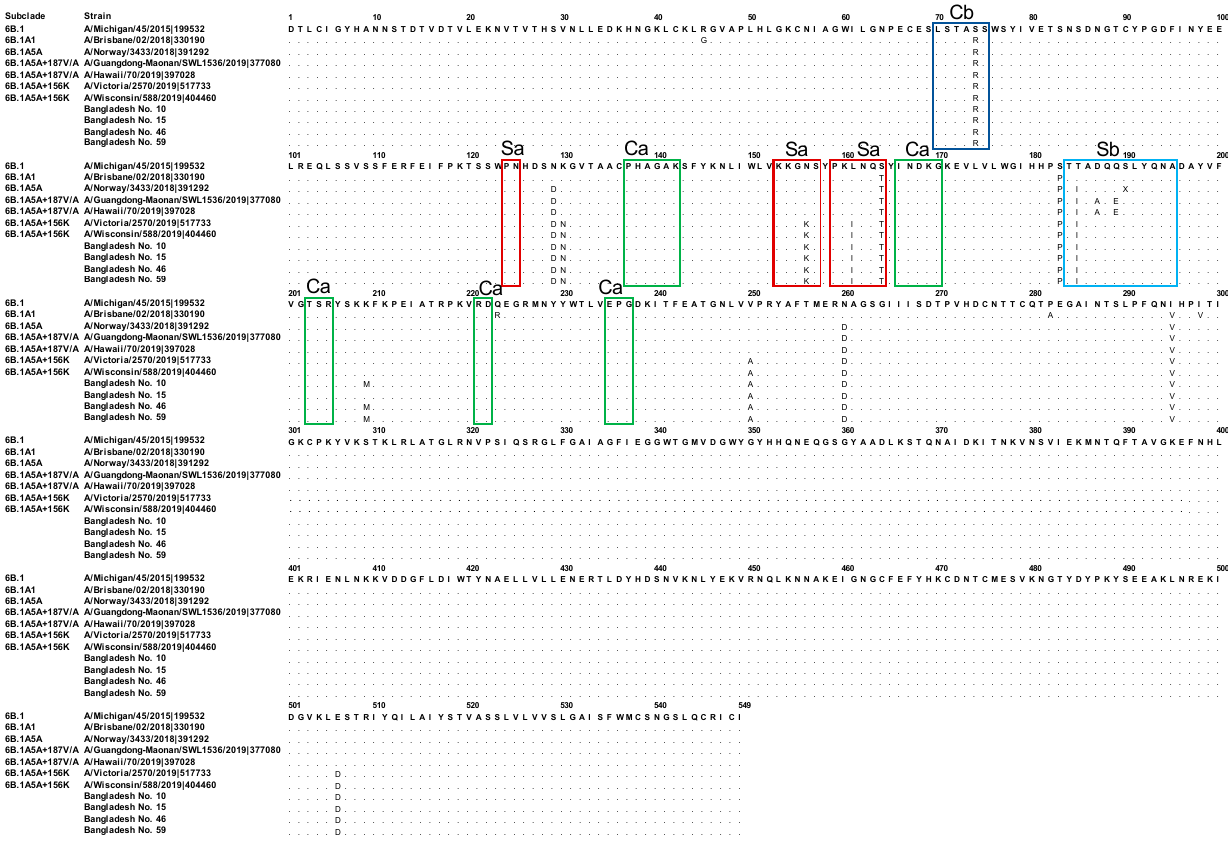
Figure 1. Alignment of the coding amino acid sequences of HA1 antigenic sites in the four strains isolated in Bangladesh in the present study. The coding amino acid sequences of HA1 were aligned to that of the reference strain, A/Michigan/45/2015. The H1N1pdm09 subclades and strain names are indicated on the left side of the figure. The amino acid sequences of each antigenic site are indicated as follows: Sa site (red box), Sb site (light blue box), Ca site (green box), and Cb site (dark blue box).